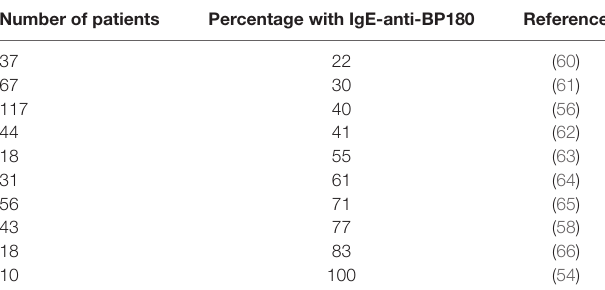
TAble 2 | Percentage of patients with bullous pemphigoid showing immunoglobulin E (IgE) reactivity to BP180. Number of patients Percentage with